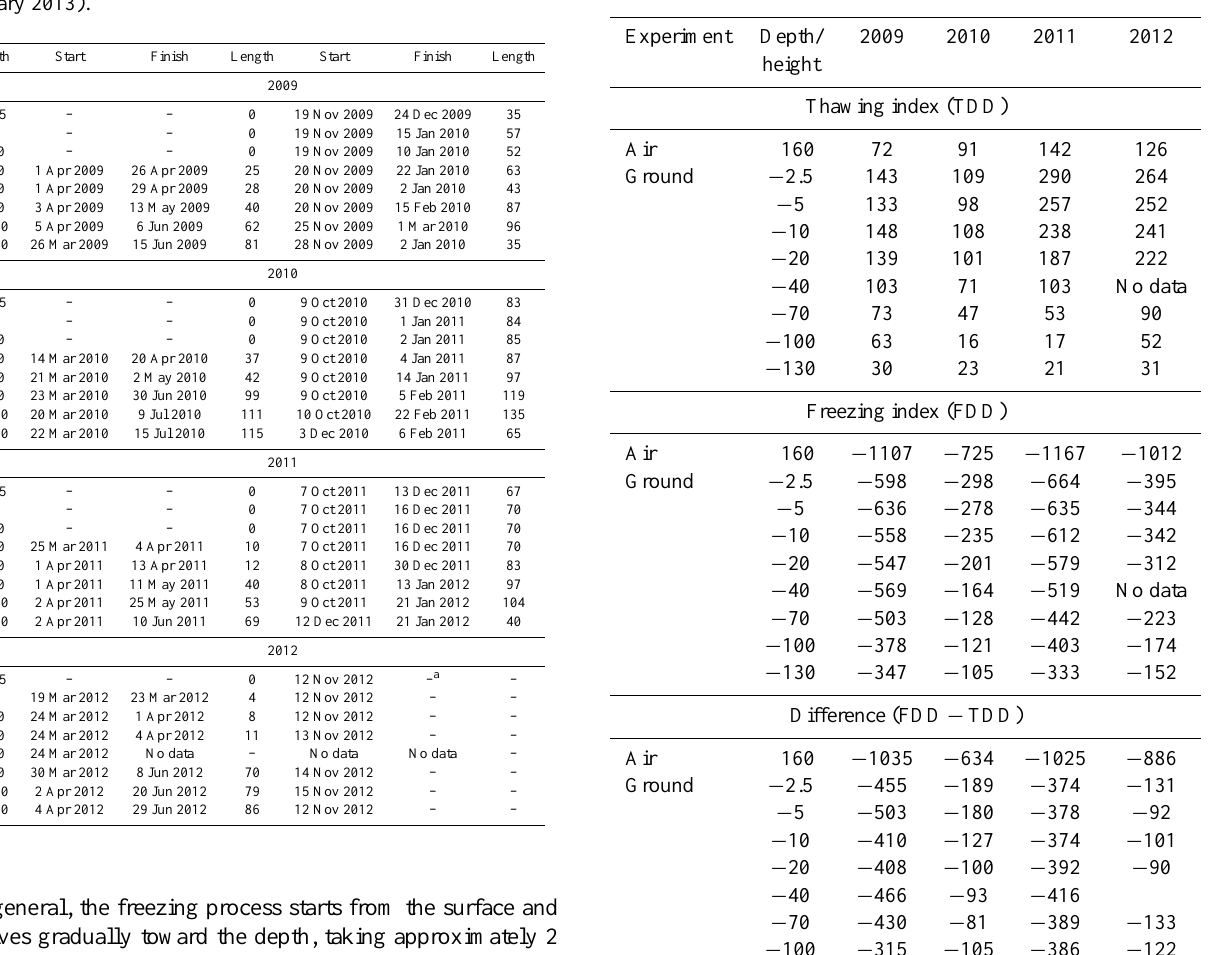
Table 5. Thawing and freezing indexes (0 ◦ Cday) of air and the ground at different depths (in cm), and the resulting difference for each depth and year in the 2009–2012